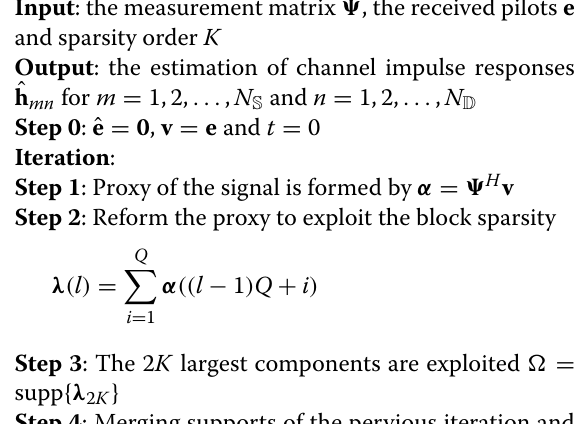
Algorithm 1 B-vCoSaMP-based channel